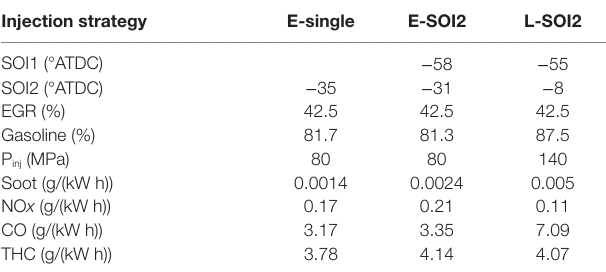
TABLe 3 | The operating parameters and emissions corresponding the maximum load in Figure 11. injection